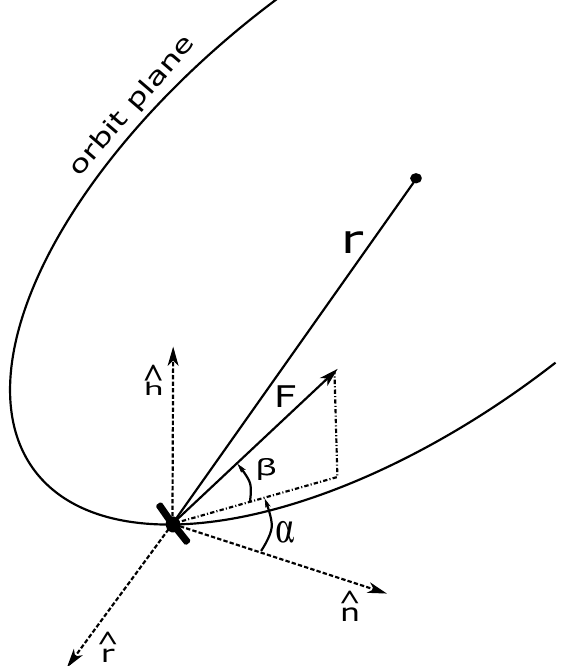
Figure 2. Control angles α and β representing the thrust directions in the reference frame N